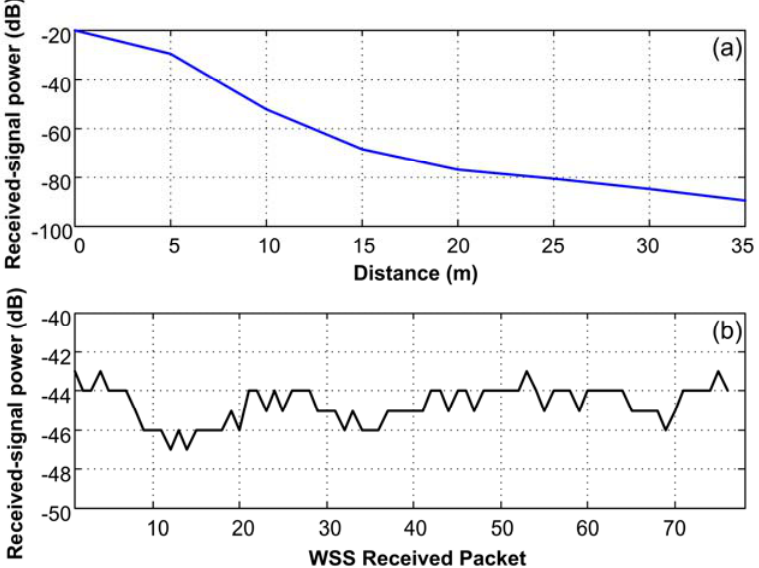
Figure 18. Received-signal power at different distances.